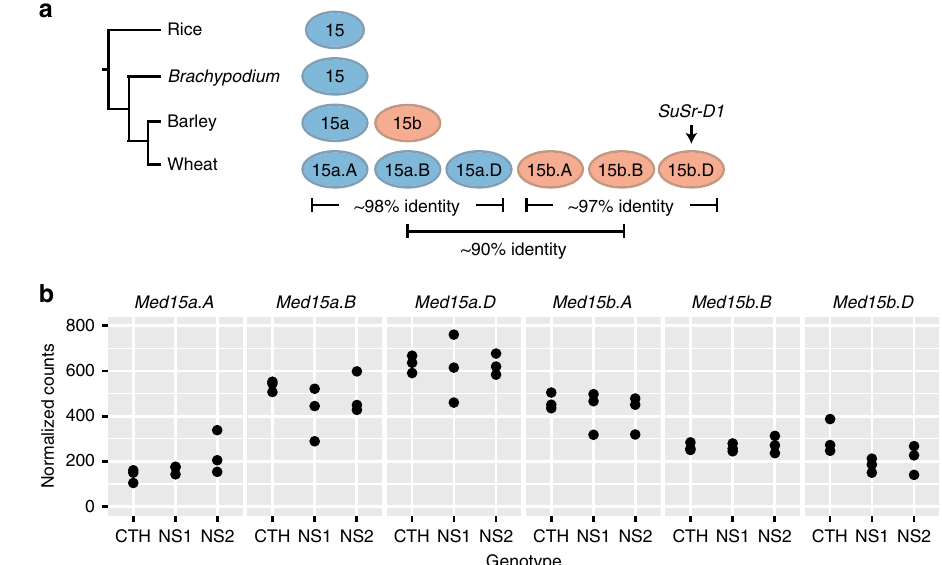
Fig. 3 Expansion of the Med15 gene family in the Triticeae. a Rice and Brachypodium distachyon have a single copy of Med15 , whereas barley and wheat have two and six copies of Med15 , respectively. Rice contains an additional Med15 gene ( Med15c ; LOC_Os04g03860) that is highly divergent in protein identity and not present in B. distachyon , barley, or wheat 31 . Homeologous Med15a and Med15b gene families exhibit 98 and 97% protein identity, whereas there was 90% protein identity between the families. b All six copies of Med15 in wheat were expressed in leaf tissue. RNAseq pro fi ling was performed in triplicate, with individual data points representing a single